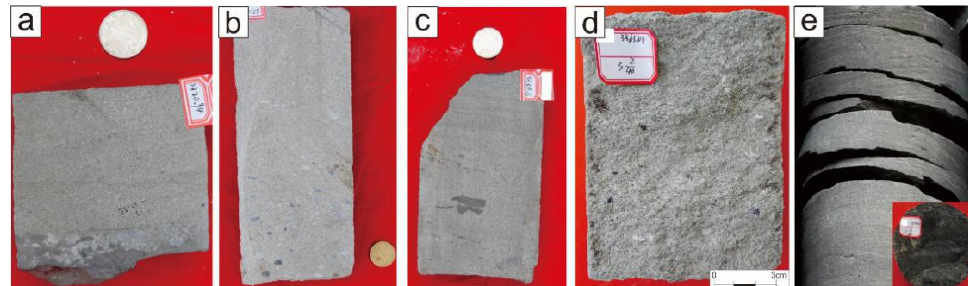
Figure 8. Lithologic characteristics in study area. ( a ) Well 94, erosion surface, 3320.94 m; ( b ) well 82, pebbly sandstone, 3330.58 m; ( c ) well 64, parallel bedding, 3338.16 m; ( d ) well 8, sandstone, 3363.04 m; ( e ) well 74, mud, 3358.03 m.